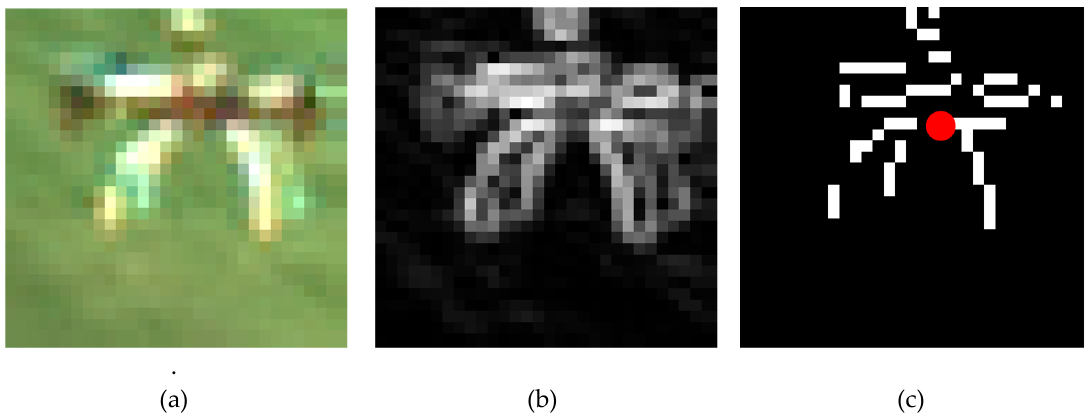
Figure 7. Example of application of the BB refinement block. In this case, the factor c is 1. (a) Detected BB. (b) Result of gradient estimation. (c) Result of binarization and centroid calculation (highlighted by a red dot).